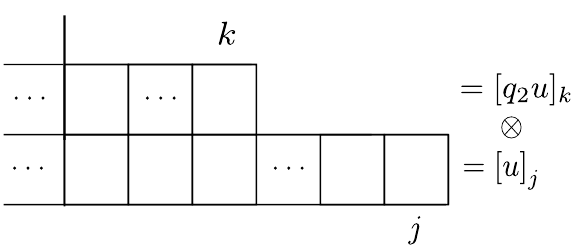
Figure 5. The basis using the tensor product of two vector representation. Each row is a 1d Young diagram, and the combination represents the tensor product of the two vector